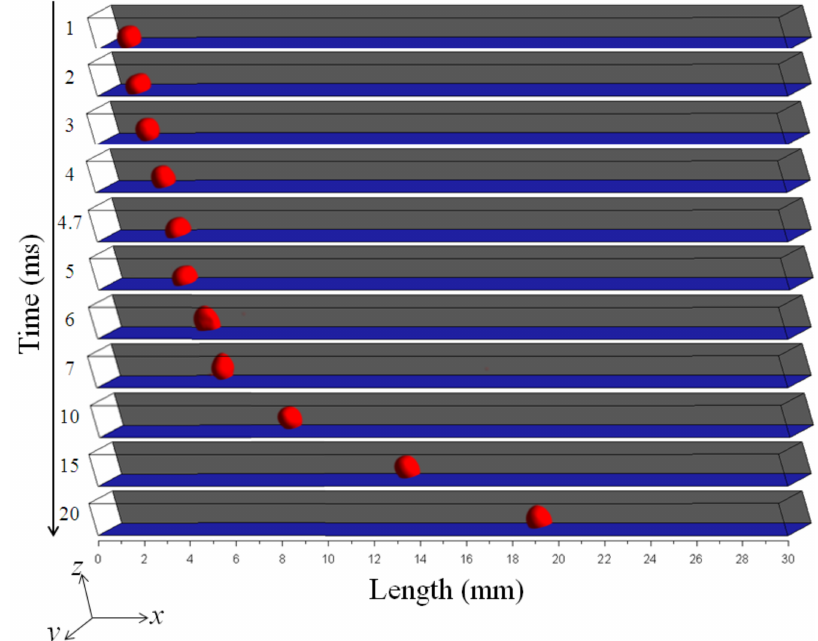
Figure 10. Water transport and dynamics in the flow channel with the channel surface contact angle of 110 ◦ , corresponding to Case 5 given in Table 1.